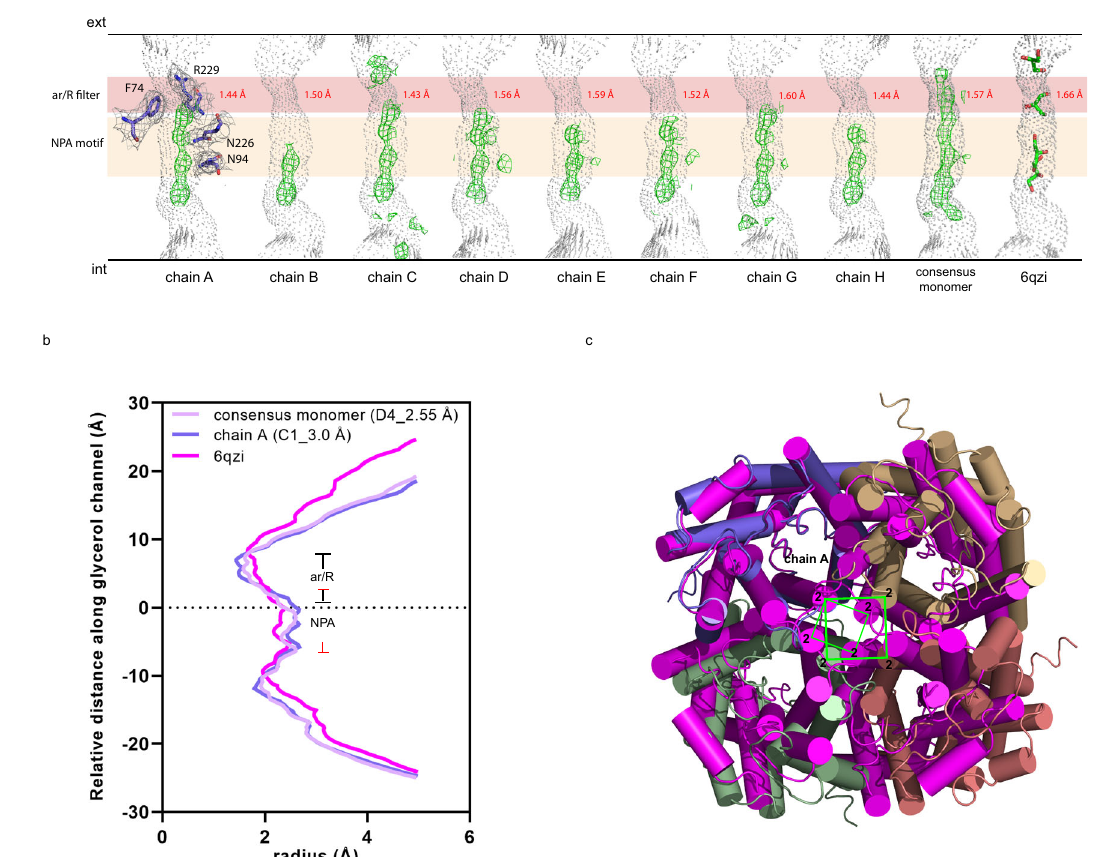
Fig.5|GlycerolchannelsinAQP7.a Glycerolchannelpro fi